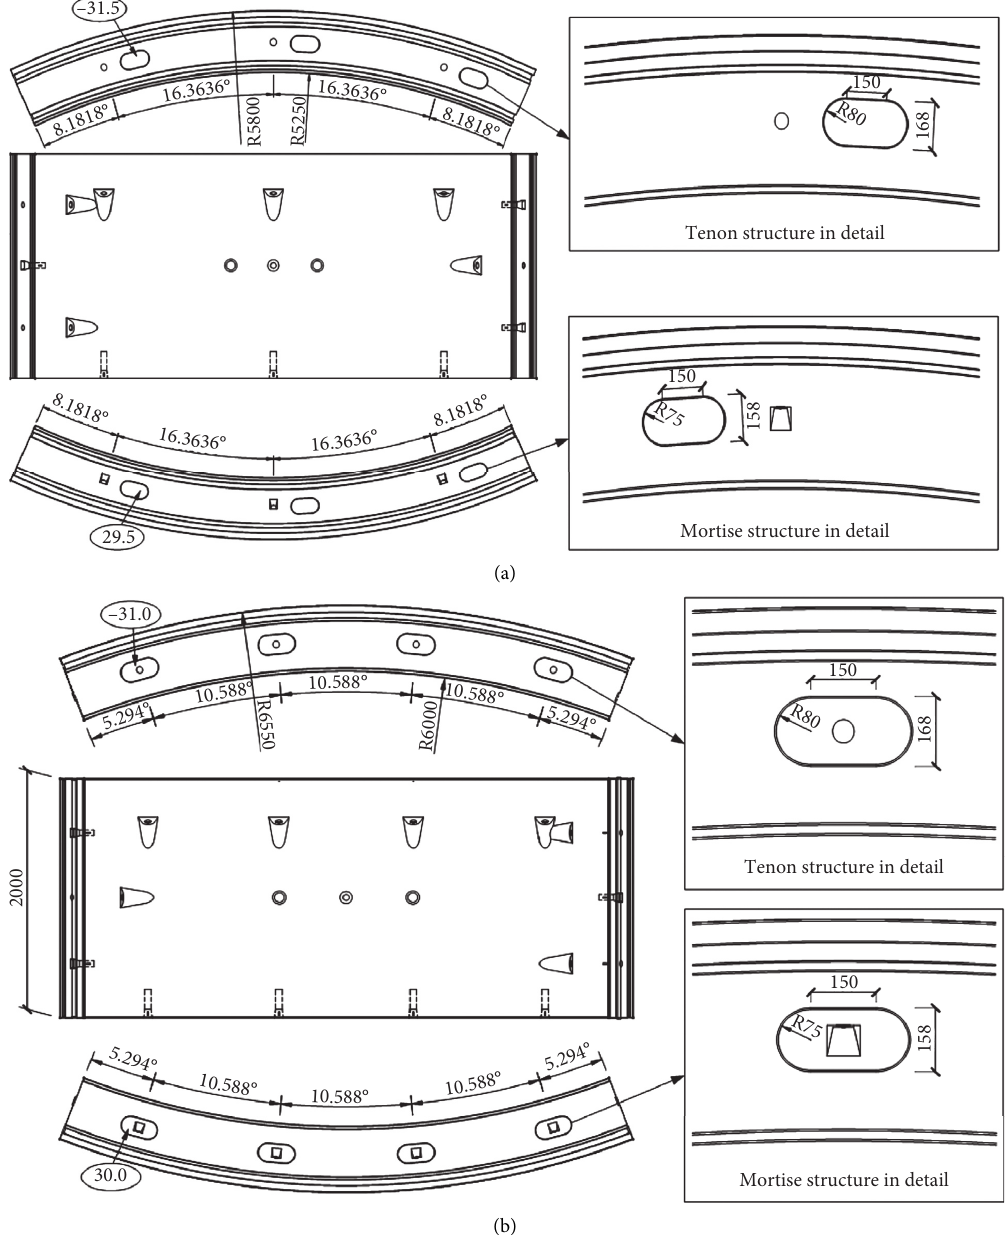
Figure 2: Schematic diagram of circumferential joints of test segments. (a) Sutong GIL Tunnel. (b) Foguan